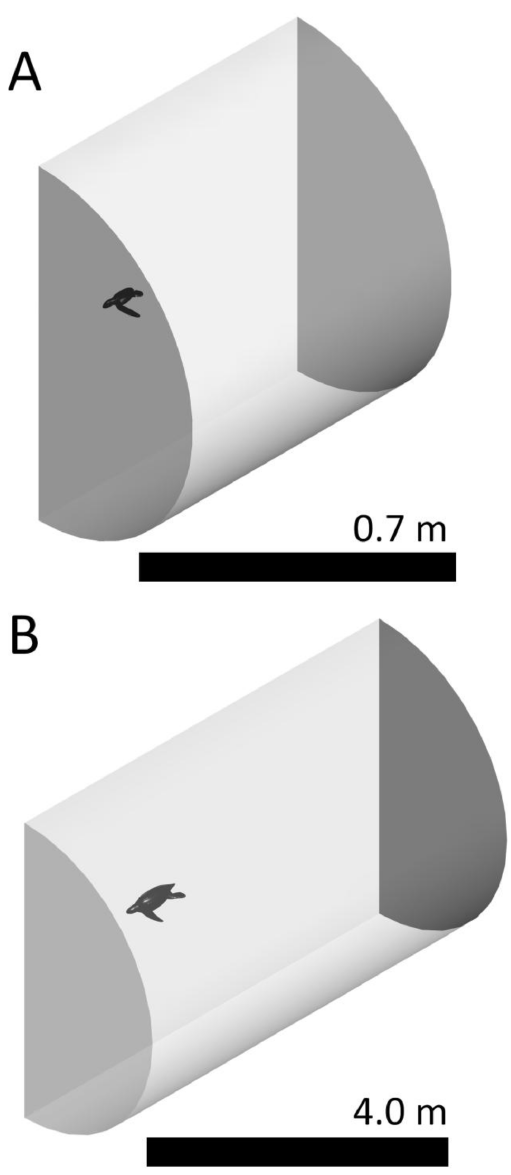
Figure 2. The volumes around the turtles. (A) The fluid volume that surrounds the moving, neonate turtle. The plane that divides the turtle had a symmetry boundary condition. This allows for reduction by half the computational fluid dynamics resource requirements. (B) The fluid volume that surrounds the moving, juvenile turtle. The plane that divides the turtle had a symmetry boundary condition. (Figure 3A, 3B, and 3C). We then imported this mesh into the CFD program ANSYS Fluent.